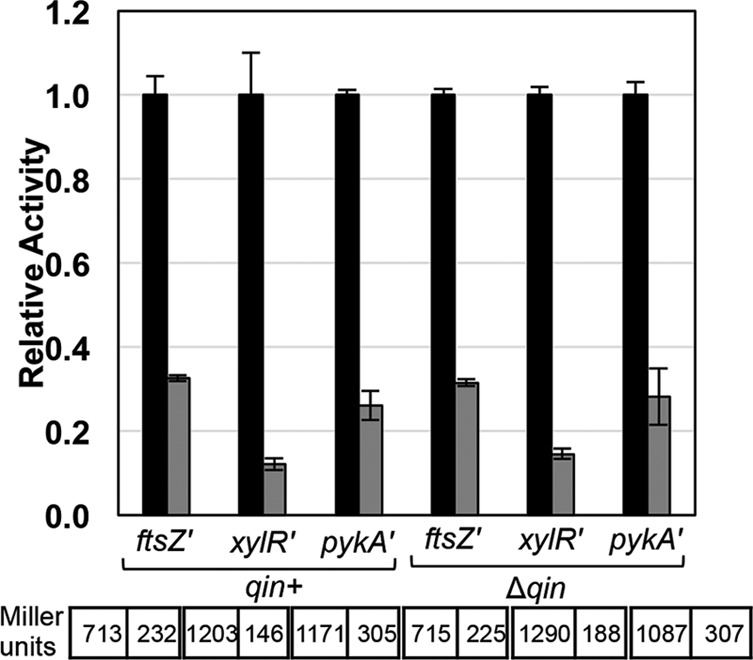
Regulation of ftsZ, xylR, and pykA by DicF does not require other factors carried on Qin prophage. β-Galactosidase activity of ftsZ′-′lacZ, xylR′-′lacZ, and pykA′-′lacZ after DicF expression was assayed in the indicated strain backgrounds. The specific activities in Miller units (indicated at the bottom) were normalized to the corresponding vector control strains to yield relative-activity data for the experimental strain.